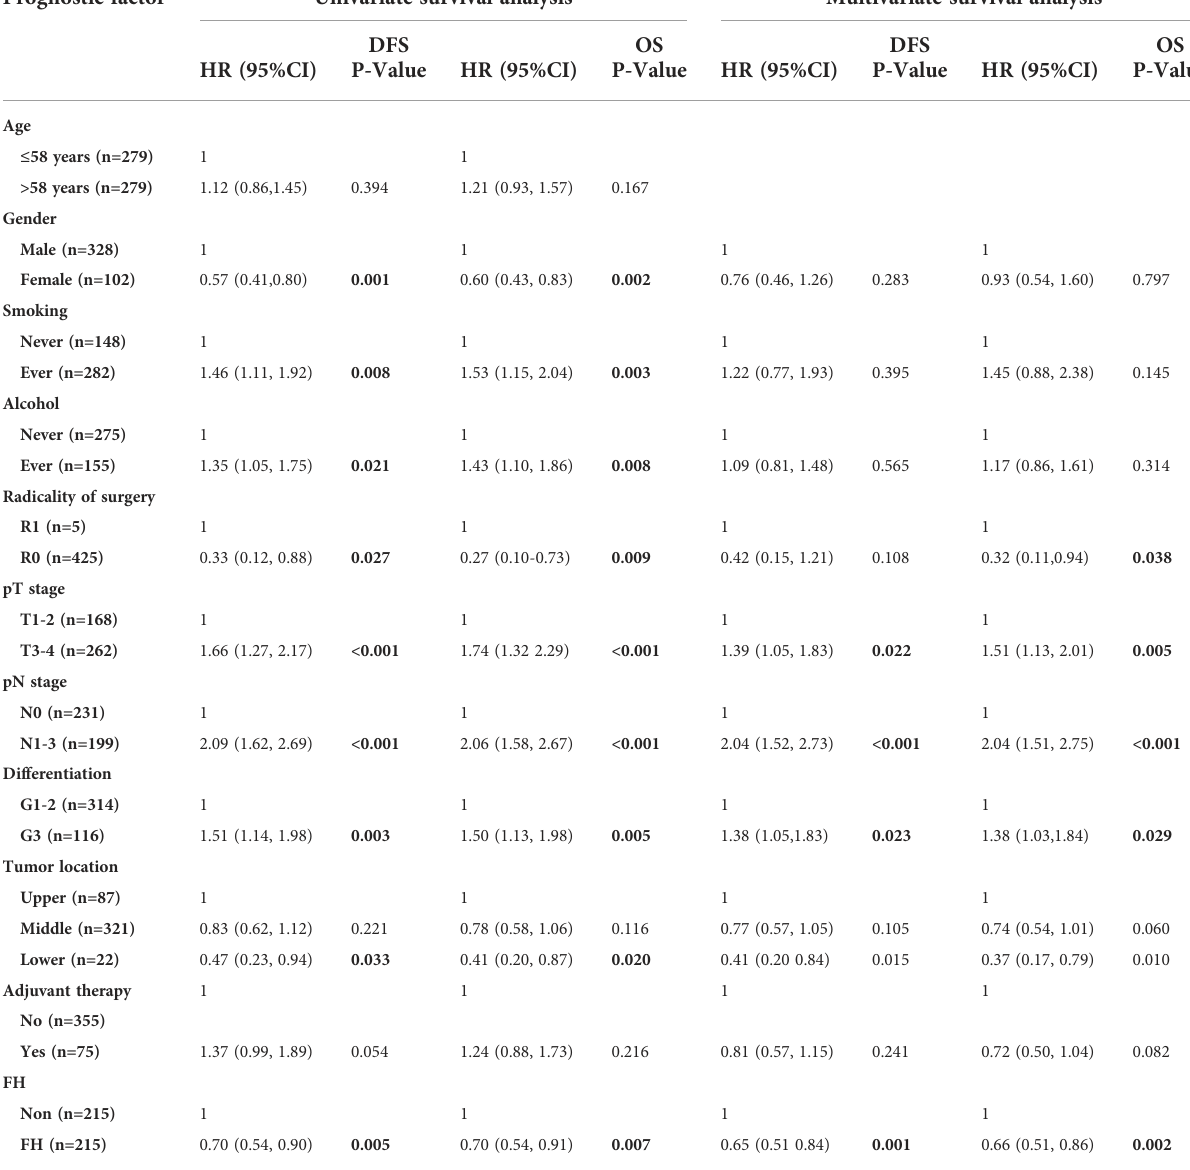
TABLE 2 Univariate and multivariate analysis for DFS, OS in patients with ESCC after PSM. Prognostic factor